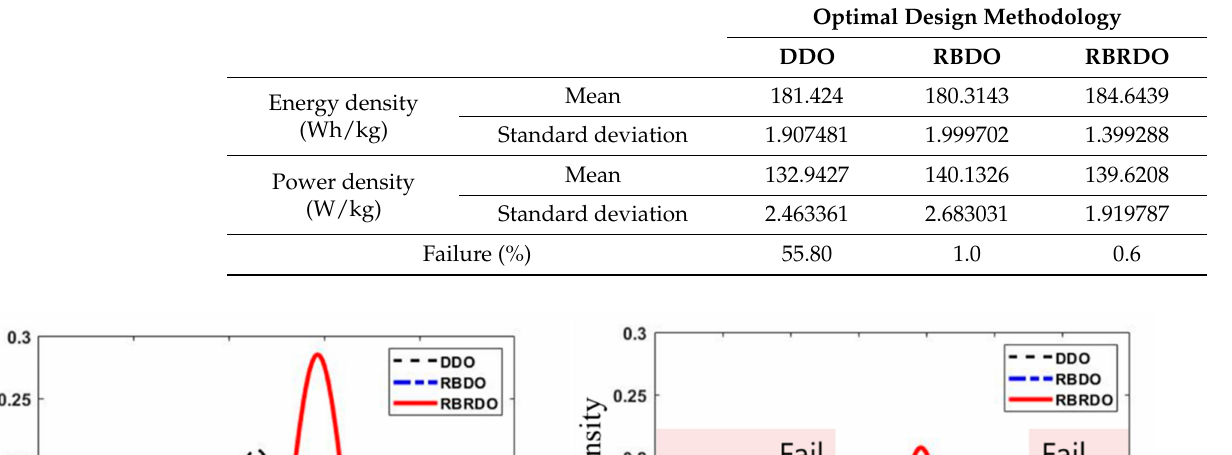
Table 5. Comparison of results obtained by DDO, RBDO, and RBRDO.